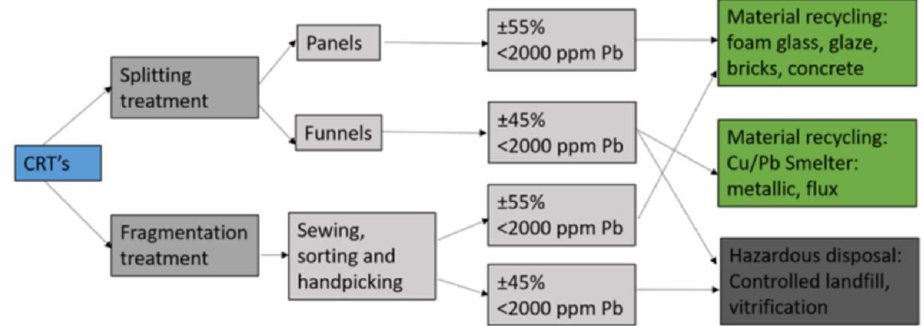
Figure 2. Current schema of treatment for cathode ray tubes (CRTs) (adapted from EERA schema) [18].